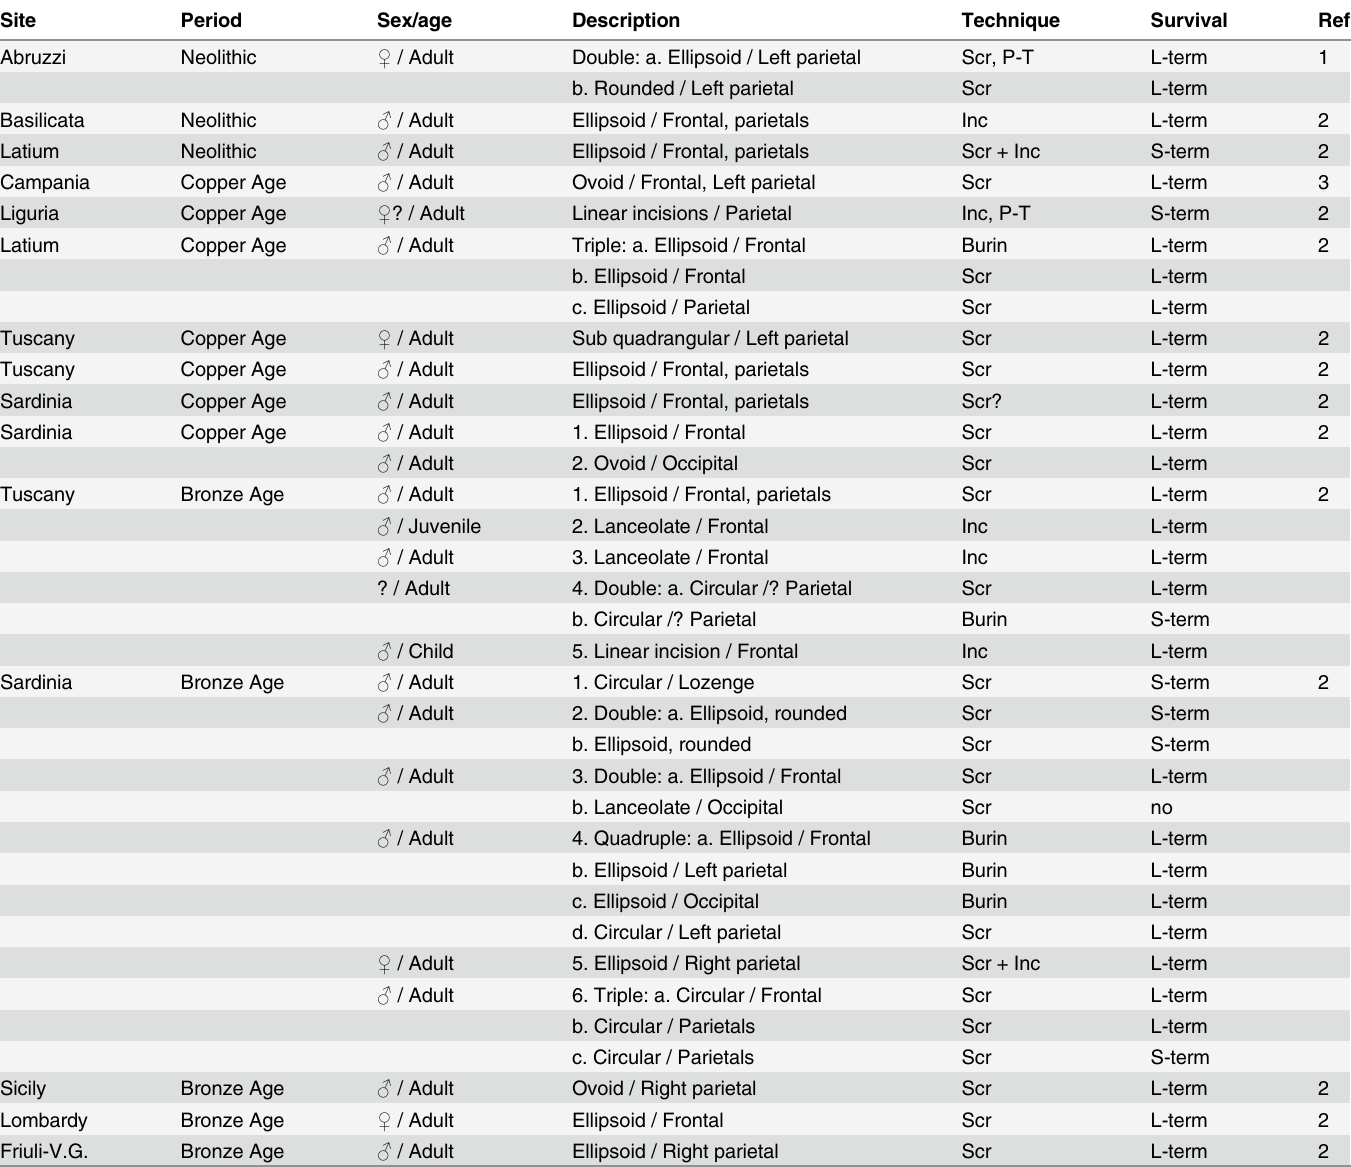
Table 1. Cases of cranial trephination in the protohistory of the Italian